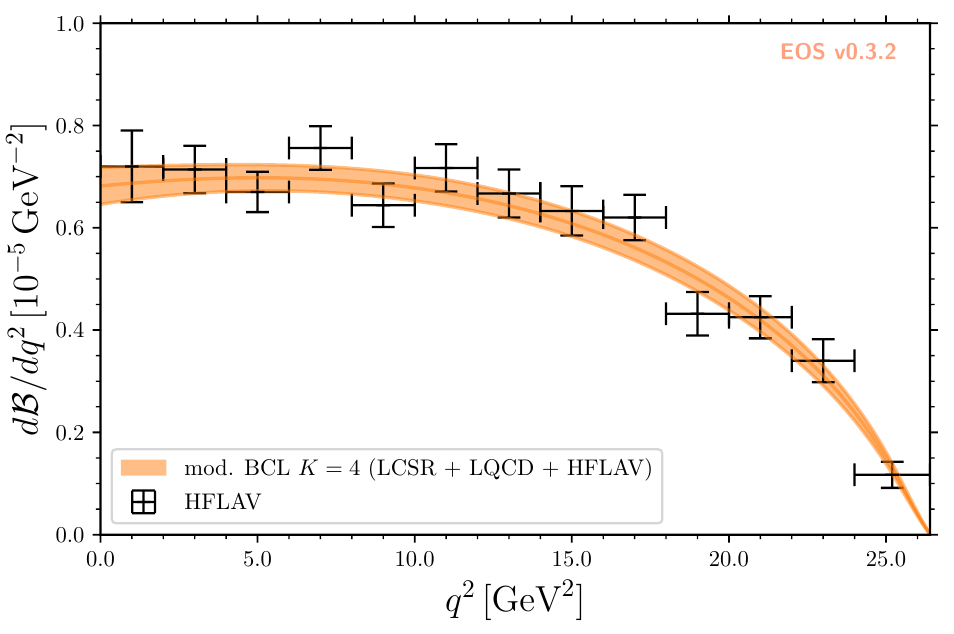
Figure 7 . Differential branching ratio for ¯ B 0 → π + ‘ − ¯ ν ‘ decay as obtained from the combined fit to LCSR and lattice QCD inputs and experimental data, compared to the HFLAV average of the experimental